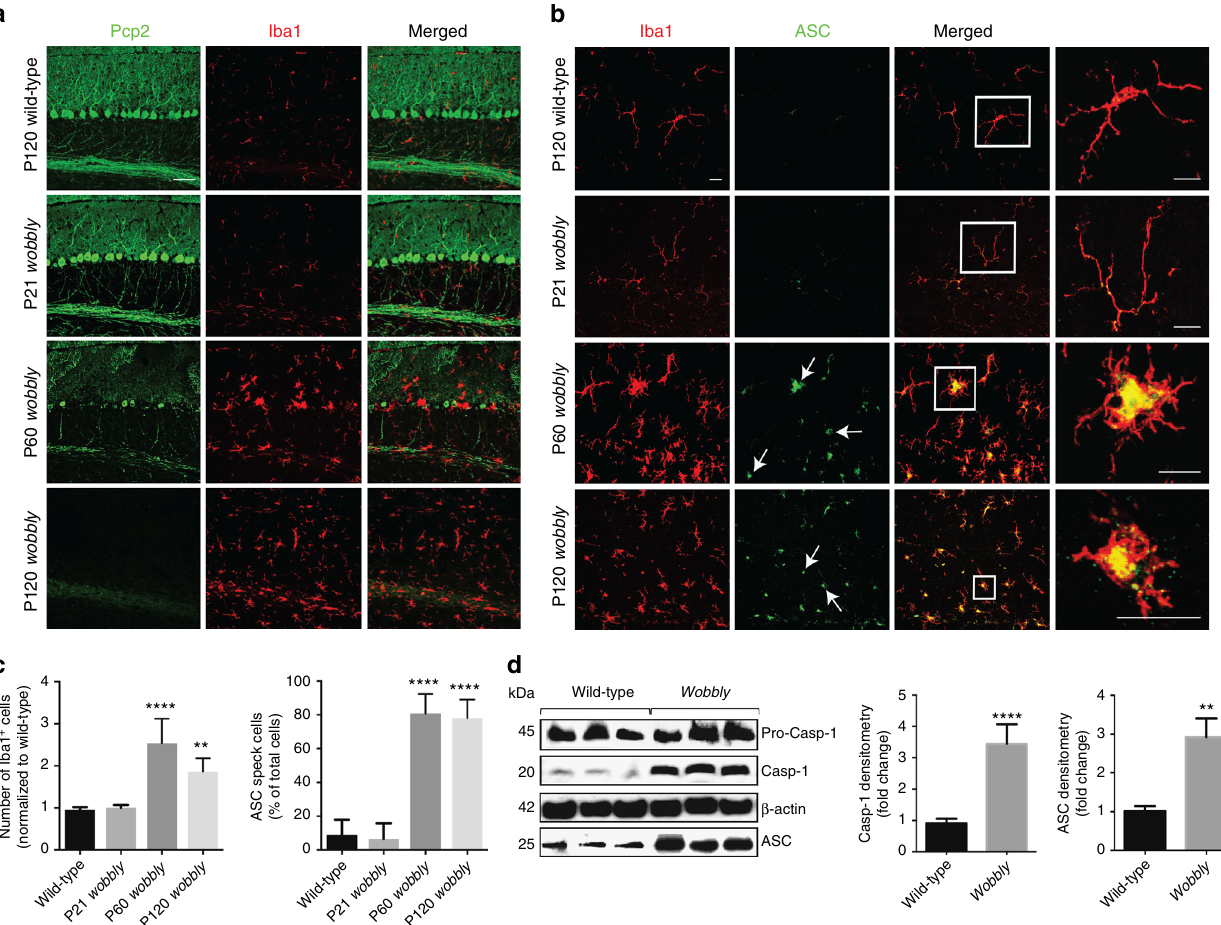
Fig. 6 Microgliosis and in fl ammasome activation in wobbly mice cerebella. a Immuno fl uorescence of wild-type and wobbly cerebella with Pcp2 and Iba1 antibodies. b Iba1 and ASC immuno-labeling of wobbly and control mice cerebellar sections. Arrows indicate ASC specks in microglia. White rectangles represent magni fi ed areas. c Quanti fi cation of microgliosis in ( a ) and ASC specks in ( b ). d Western blot and quanti fi cation of cleaved caspase-1 (Casp-1) and ASC expression in P120 wobbly cerebellar brain lysates relative to control. For all experiments n = 5 for each of the genotypes; representative images and blots are shown. Scale bars: ( a ) 50 μ m; ( b ) 10 μ m. Statistical evaluation: ( c ) two-way ANOVA and Sidak ’ s multiple comparisons test; ( d ) two-tailed t test. Statistically signi fi cant differences are indicated ( ** P ≤ 0.01; **** P ≤ 0.0001). Data represent mean ±